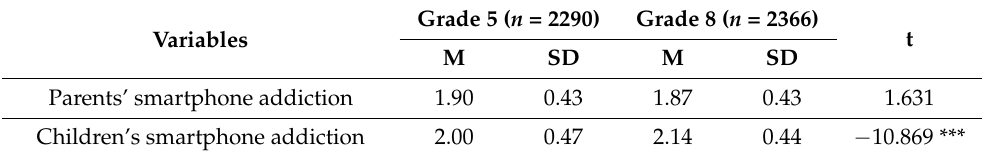
Table 4. Differences in the main variables by children’s